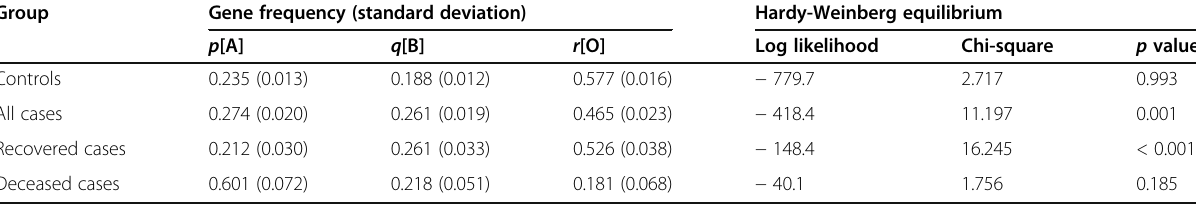
Table 3 Gene frequency of ABO blood group alleles among coronavirus disease 2019 cases and controls Group